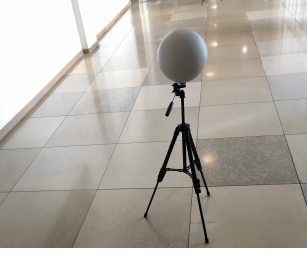
removable magnetic base (M8 thread).